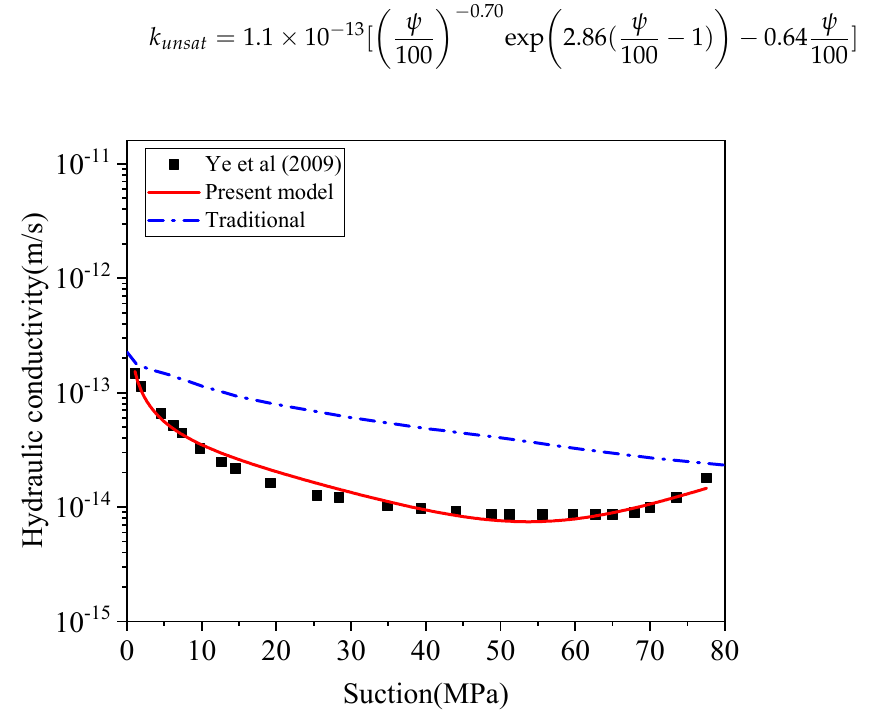
Figure 8. The prediction of unsaturated hydraulic conductivity for GMZ bentonite.